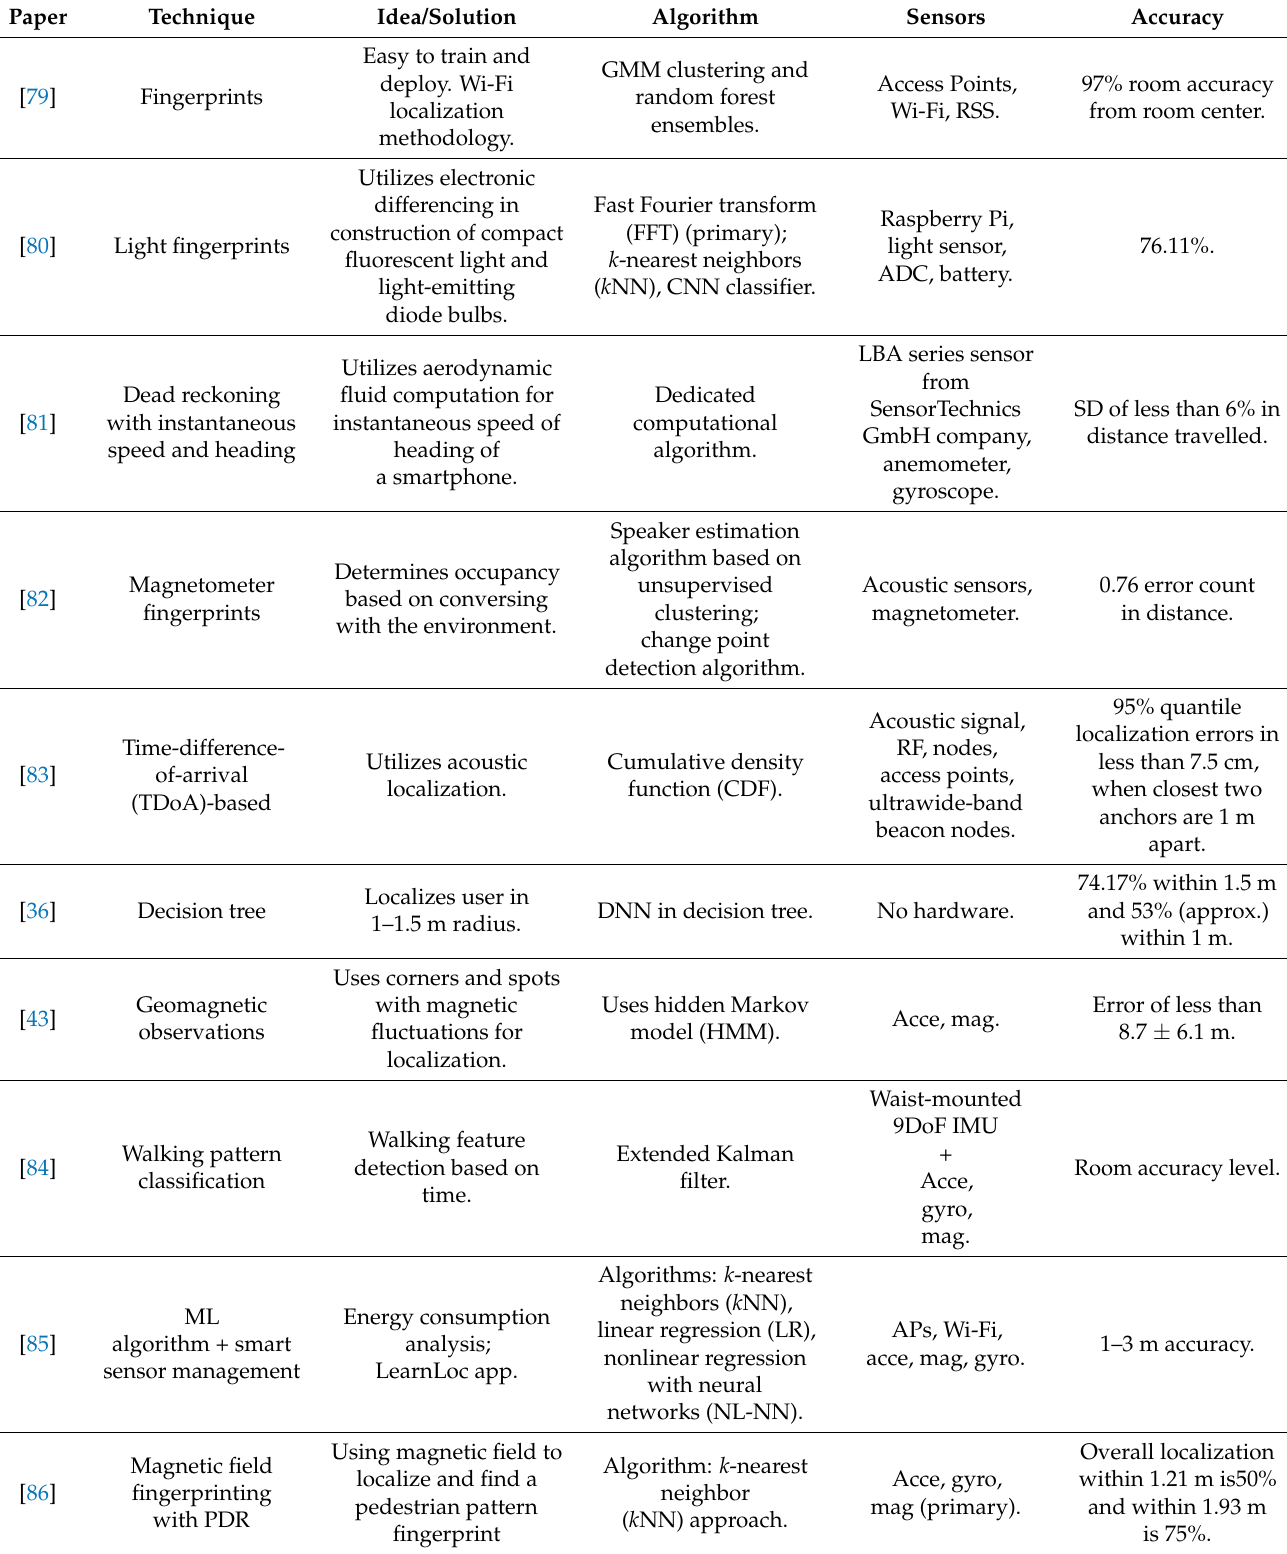
Table 4. Indoor localization and tracking